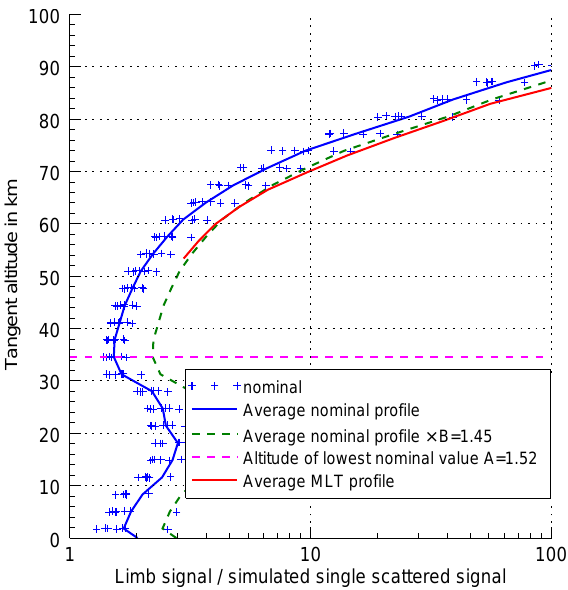
Figure 12. Measured radiance to simulated single scattering ratio calculation for an MLT and co-located nominal limb measurements. The albedo factor is the product of AB ( AB = 2 .